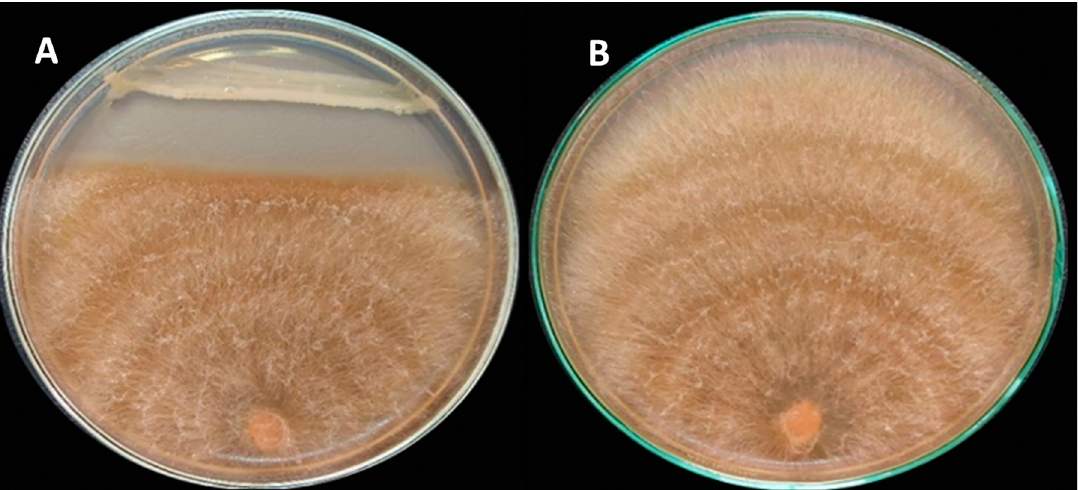
Figure 2. Plates of the in vitro anti-biological activity of the endophytic bacterium; F23KW against R. solani RT8, show the antagonism between the dual cultured R. solani and F23KW strain ( A ), in comparison with the solely grown R. solani on the PDA plate ( B ).